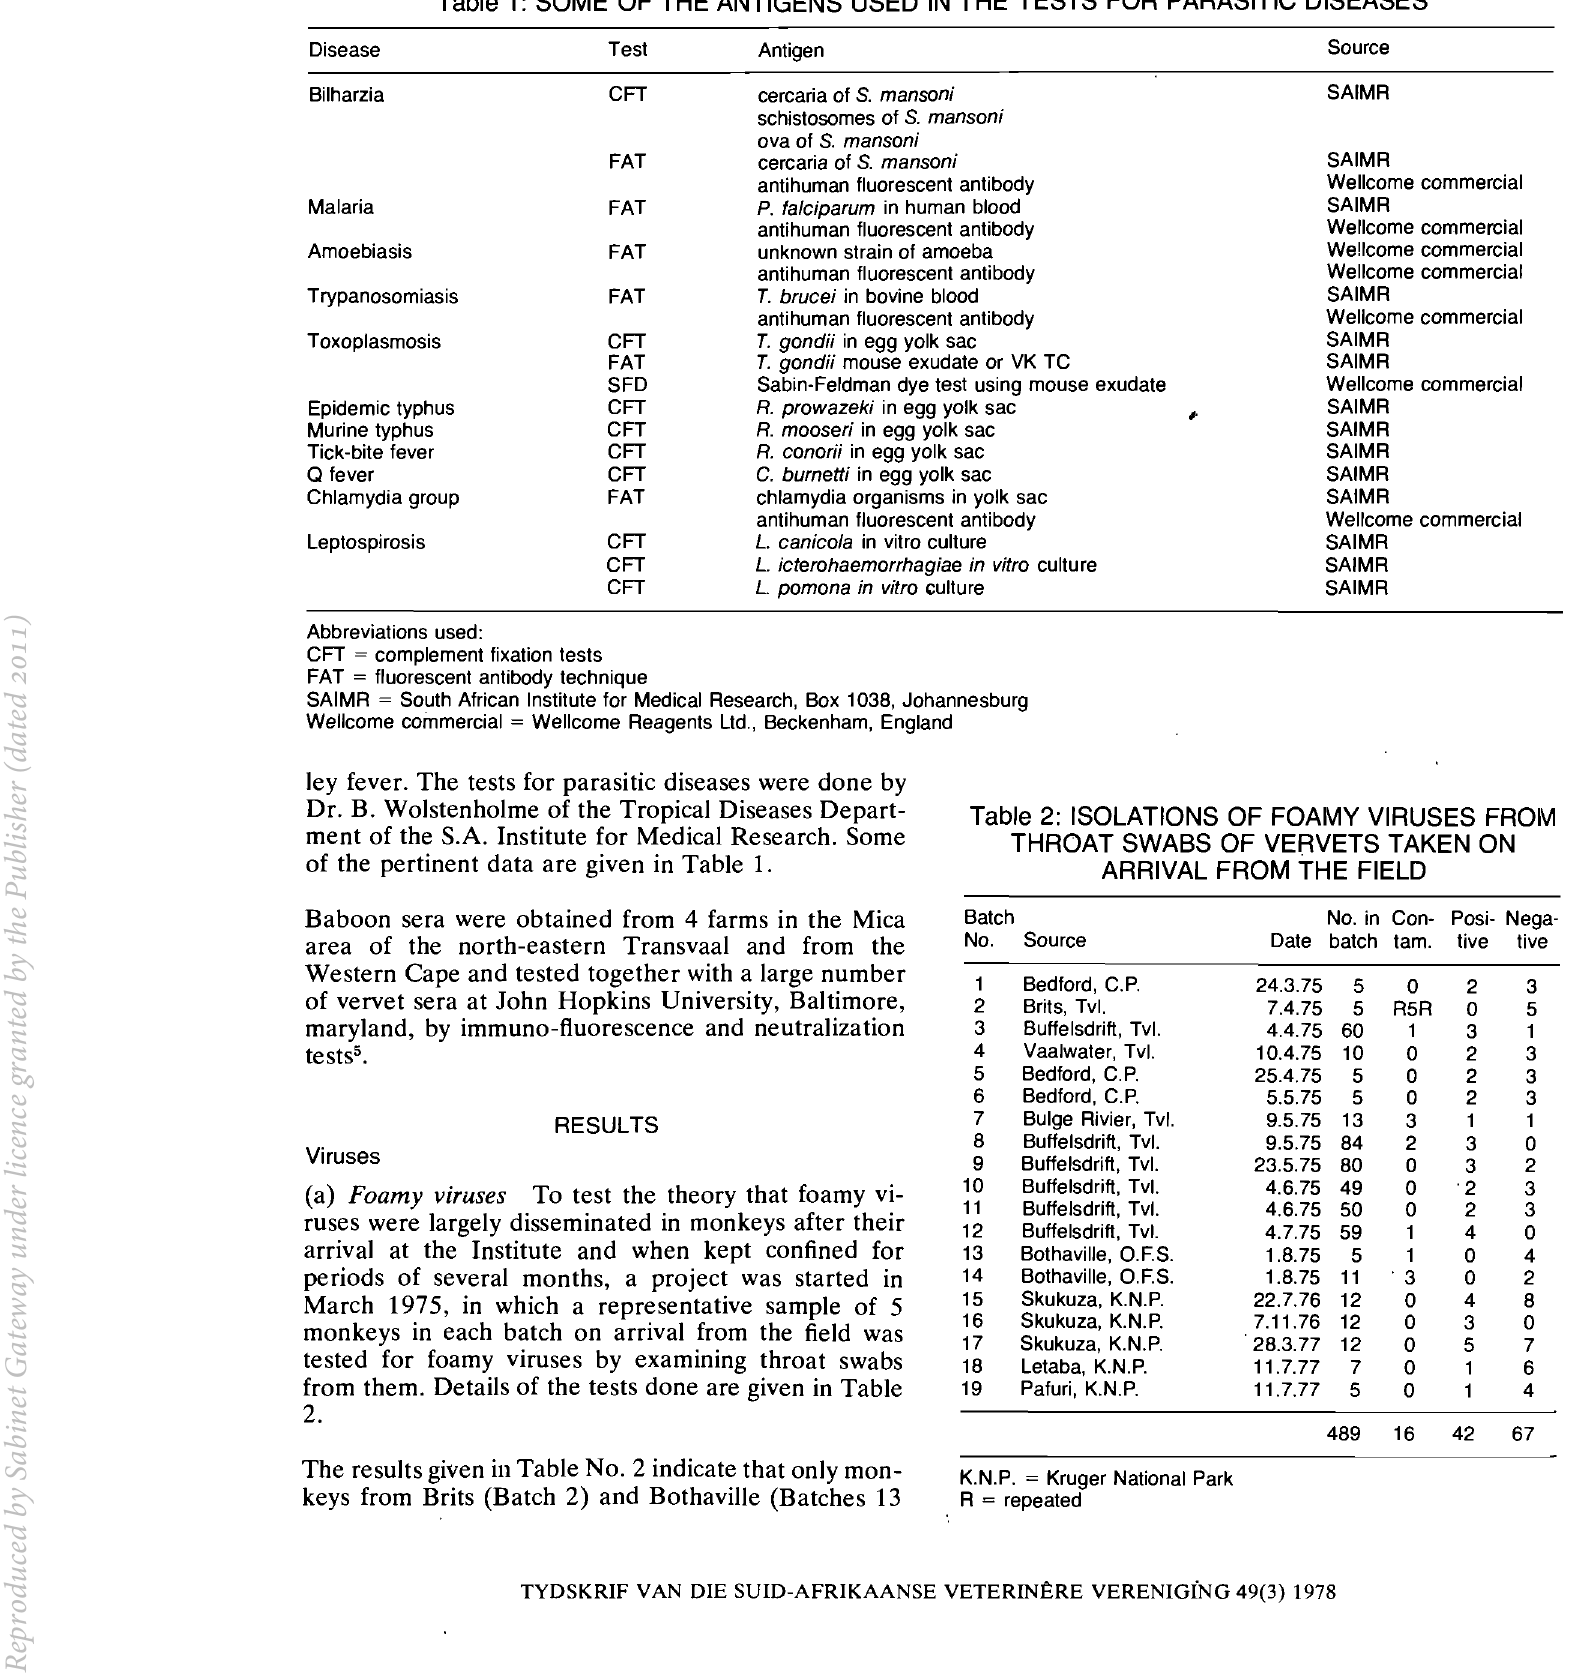
Table 2: ISOLATIONS OF FOAMY VIRUSES FROM THROAT SWABS OF VERVETS TAKEN ON ARRIVAL FROM THE